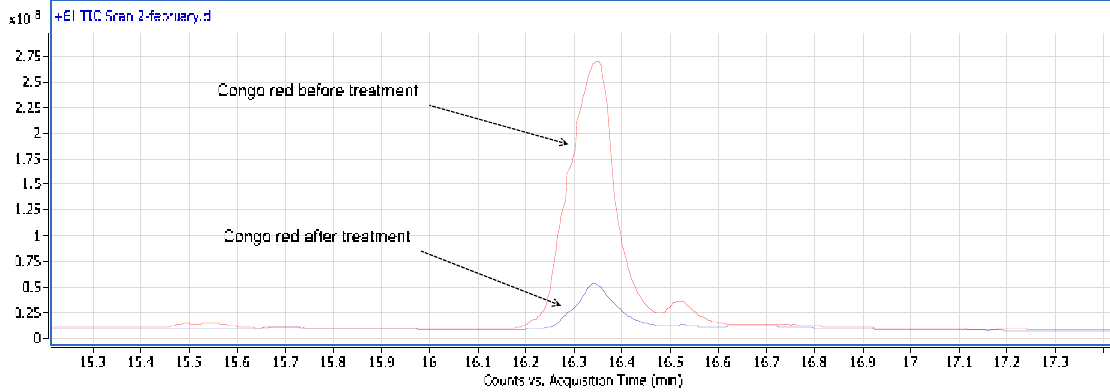
Fig. 9: GC-MS Chromatogram of control sample vs treated Fig. 9: GC‐MS Chromatogram of control sample vs treated sample